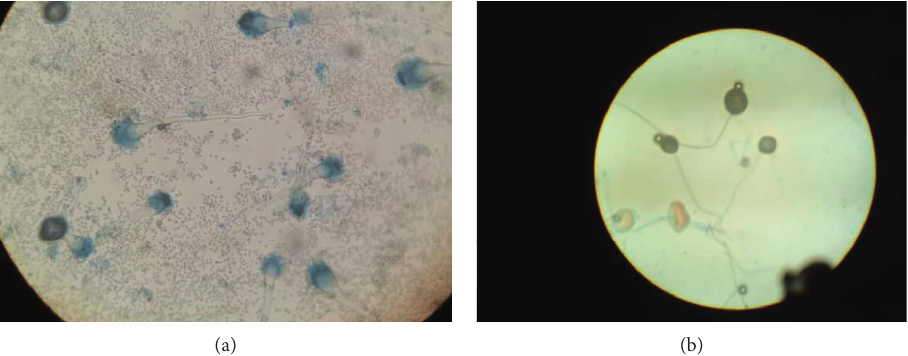
Figure 6: Microscopic examination of cultured fungi revealed results consistent with Aspergillus fumigatus (a) and Rhizopus arrhizus (b).